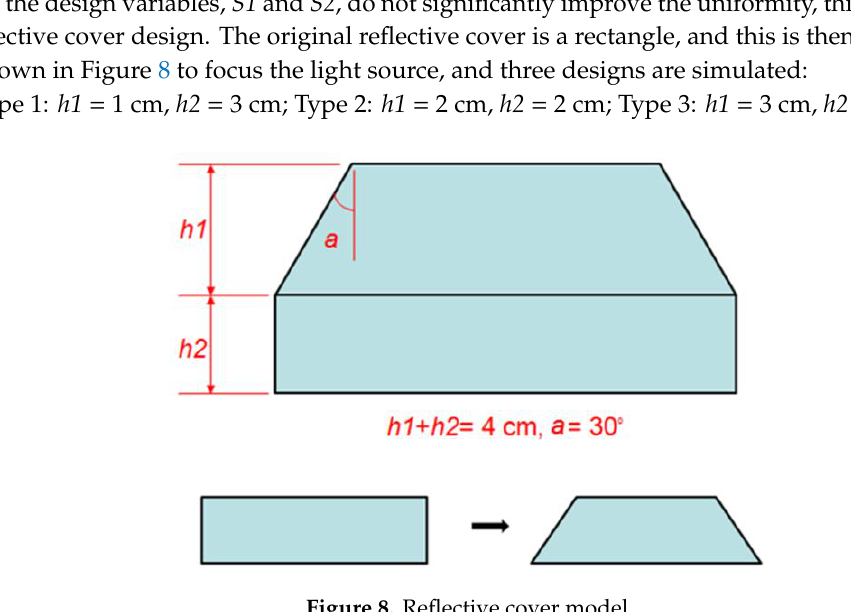
Figure 8. Reflective cover model.